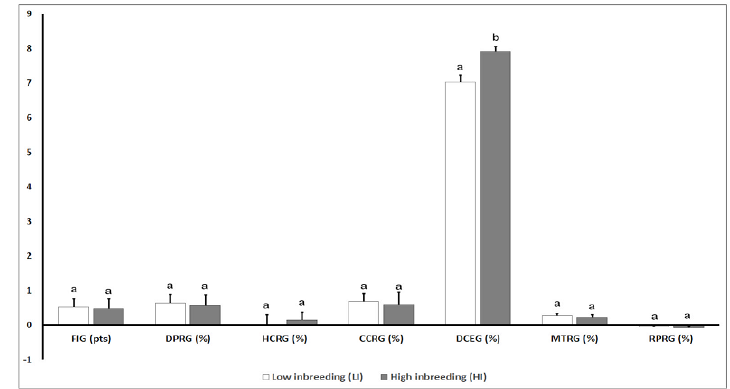
Figure 4. Effect of the degree of inbreeding (LI versus HI) on genomic parameters for reproductive traits in high-producing primiparous dairy cows. Reproductive genomic values: FIG: Fertility Index; DPRG: Daughter Conception Rate; HCRG: Nulliparous Cow Conception Rate; CCRG: Cow Conception Rate; DCEG: Daughter Calving Ease; MTRG: Resistance to Metritis; RPRG: Resistance to Placental Retention; NS: Not Significant; SEM = Standard Error of the Mean. Different letters show statistical differences between values ( p ≤ 0.05). pts: points; %: Percentage; SEM: Standard Error of the Mean.